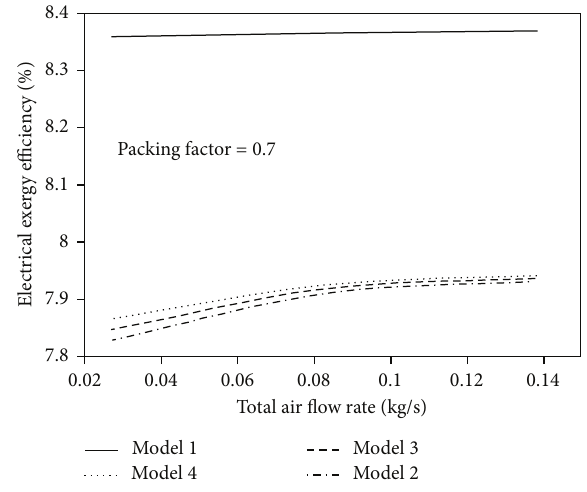
Figure 4: Electrical exergy of the four panel designs.